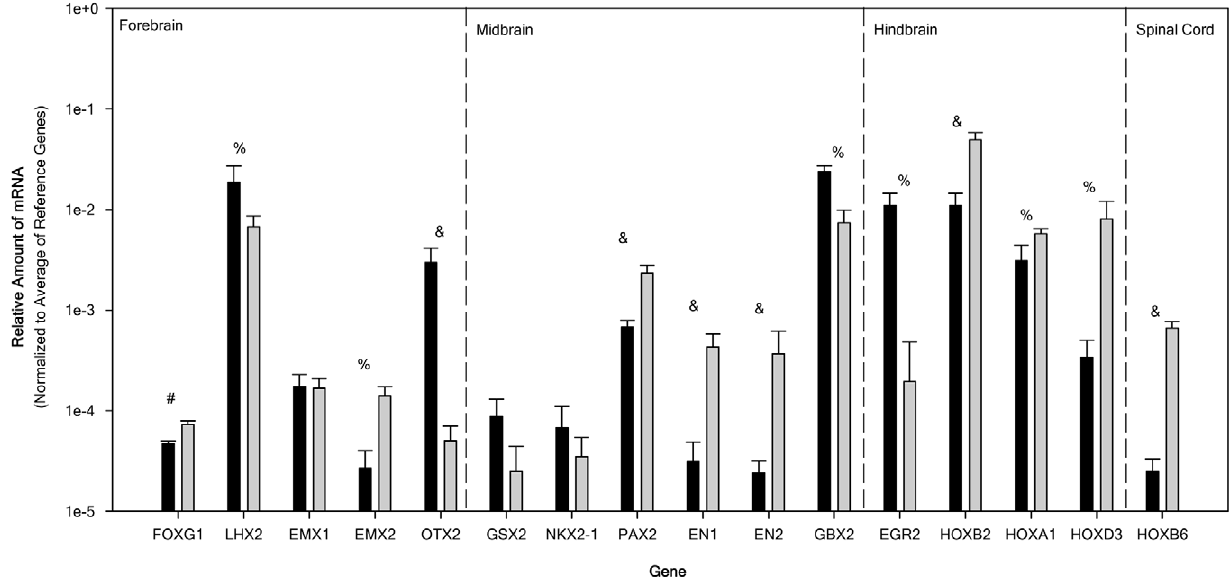
Figure 5. Relative mRNA expression of regional specific transcription factor genes in the rostocaudal direction for NTERA2 (NT2) cells and purified NTERA2 all-trans retinoic acid differentiated neurons (NT2N). Relative amount of mRNA normalized to the average of 3 reference genes (G3PDH, PPIA, and NUBP1). Relative amounts of mRNA for NT2 (black bar) and NT2N (gray bars) were obtained from 6 passage matched cultures (ranging from 25–36) and all samples were analyzed independently in triplicate. Genes are given from rostral to caudal direction (left to right). Dashed lines divide genes for the forebrain, midbrain, hindbrain, and spinal cord. All data are expressed as the average relative gene expression + SEM. For the comparison of NT2 to NT2N: # p , 0.05, % p , 0.01, and & p , 0.005.